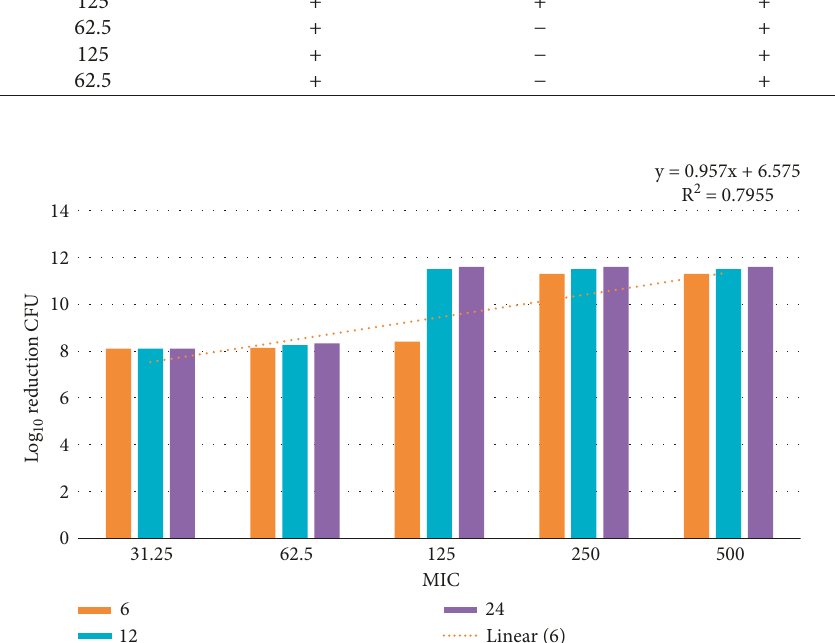
Figure 10: IC50 for the C5 compound from 1X to 16X of MIC for 6, 12, and 24 hours against S. aureus